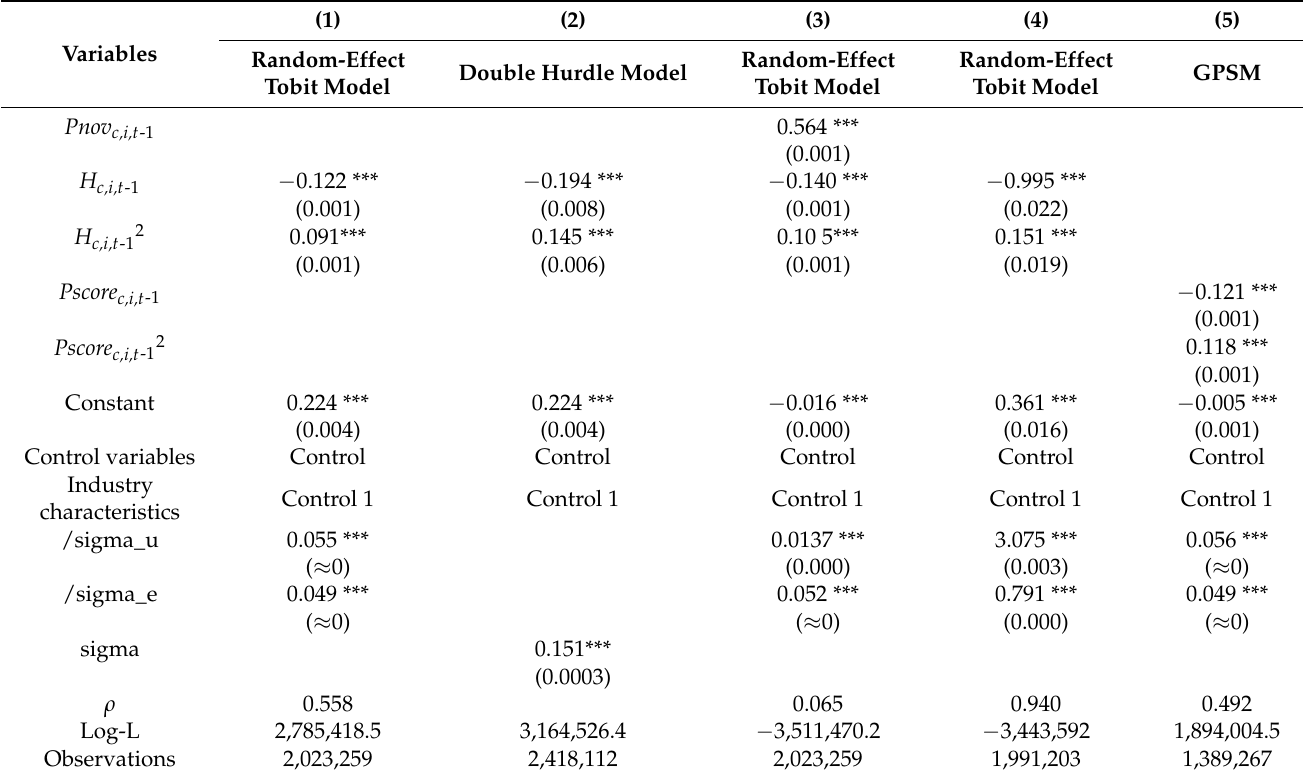
Table 6. Environmental compliance and enterprise innovation: